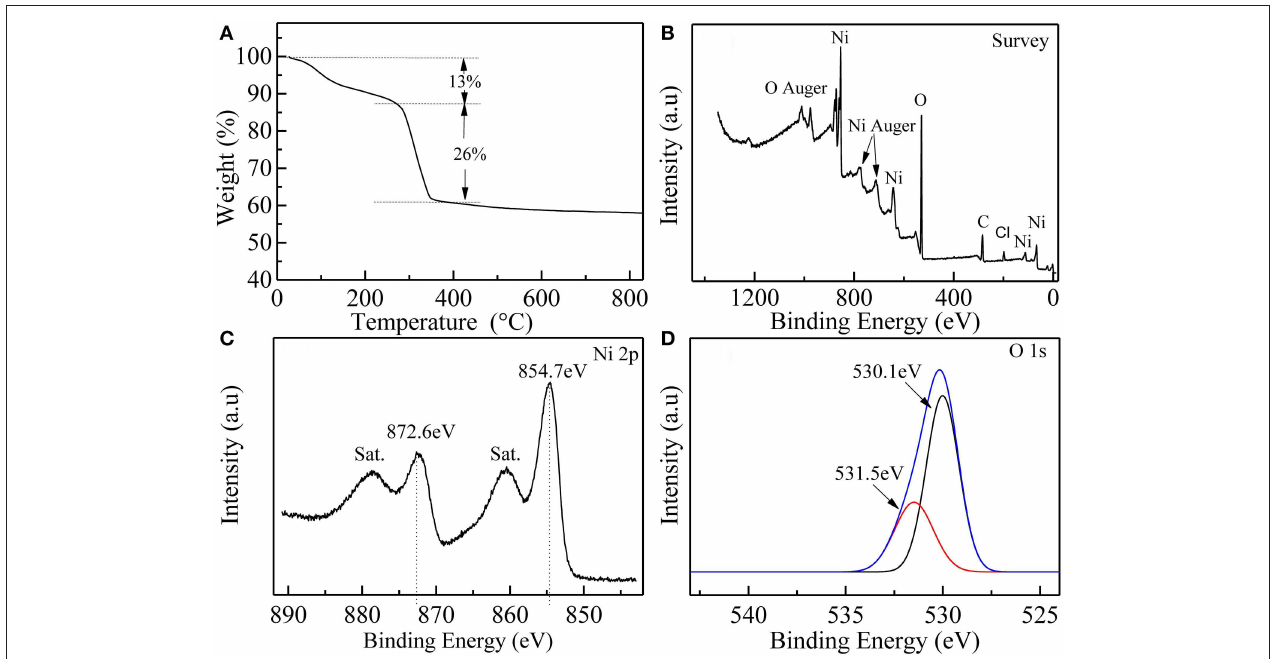
FIGURE 4 | (A) The TG curve of α -Ni(OH) 2 -MS. The XPS spectra of (B) Survey, (C) Ni 2p, and (D) O 1s from α -Ni(OH) 2 -MS.